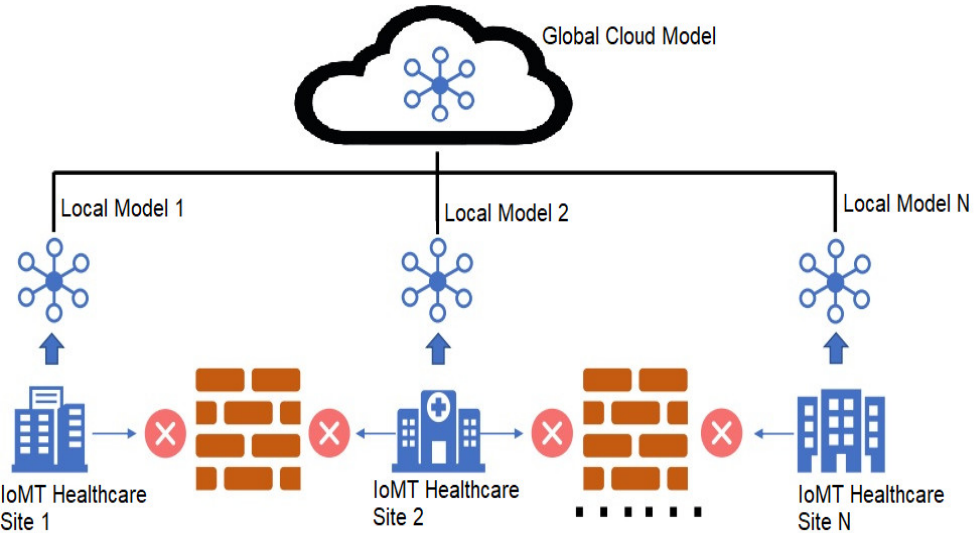
Figure 1. Overview of proposed framework.